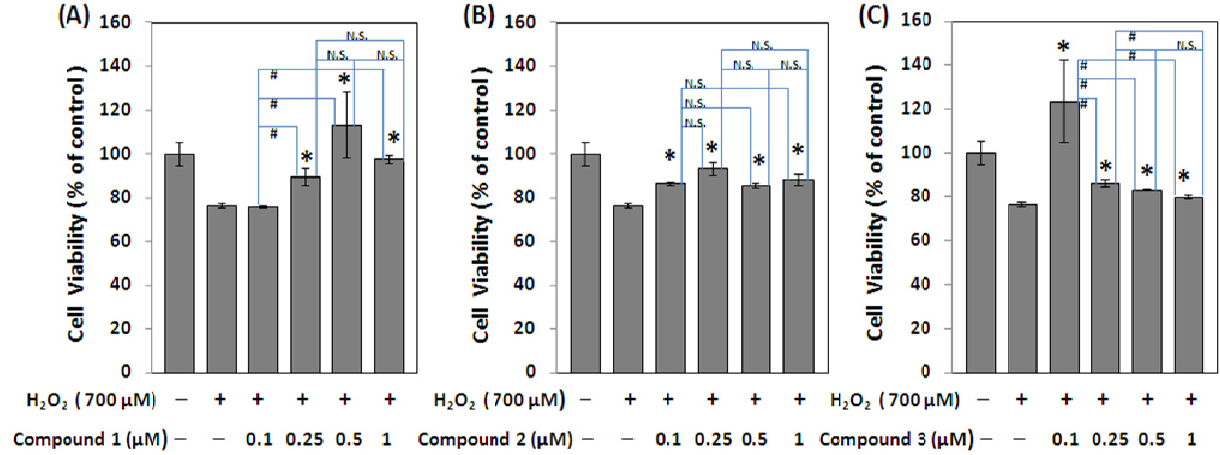
Figure 3. Protective effect from H cells of ( A ) compound 1 ; ( B ) compound 2 ; and ( C ) compound 3 . The cell viability is expressed as a percentage relative to control without H mean ± SEM from three experiments. The asterisk symbol (*) indicates a statistically significant difference ( p < 0.05) in relation to control with H indicates a statistically significant difference ( p < 0.05) between each experimental group. N.S. means not